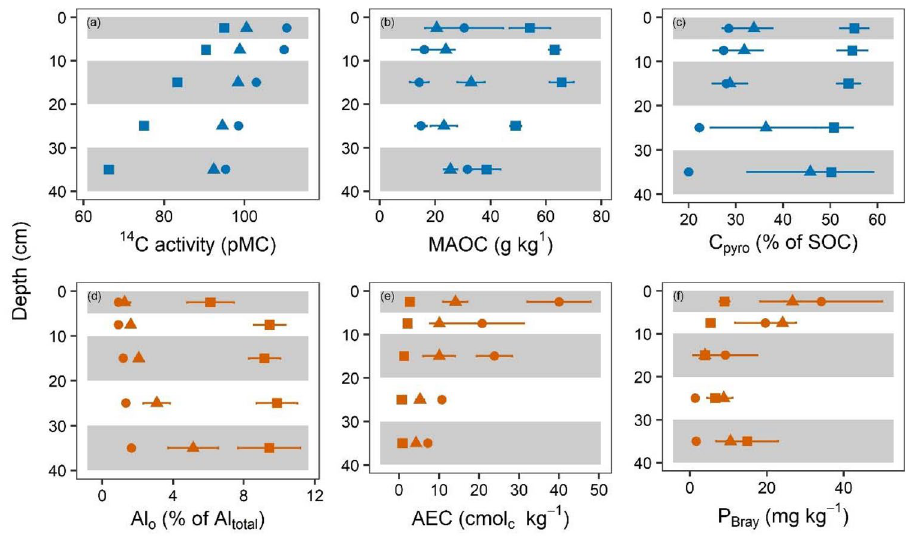
Figure 1. Depth profiles of selected soil carbon persistence indicators (blue) and soil quality indicators (orange). Managed pastures (MP) are displaced as squares and pristine sites as triangles (grassland, PG) and circles (forest, PF). Mean values and standard errors (b-f; n = 3). ( a ) The fraction of modern carbon indicates the apparent 14 C age of the soil carbon associated with fine (< 63 µm) mineral phase (only for this parameter